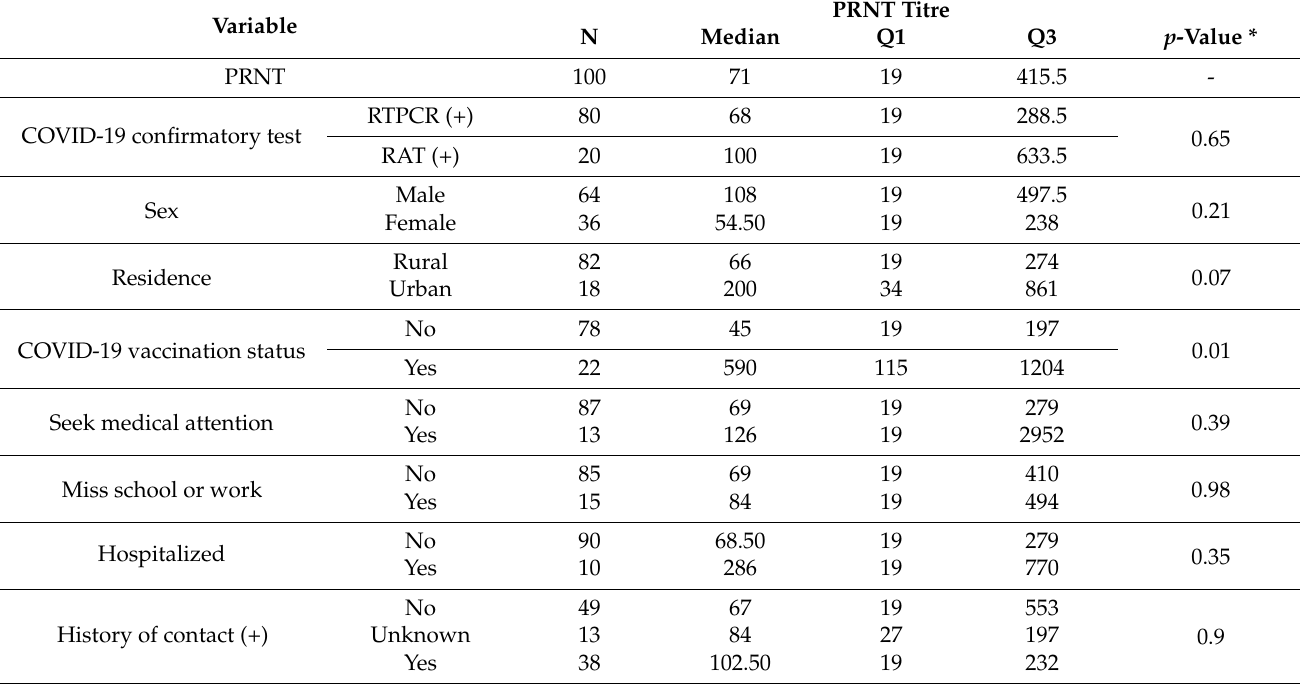
Table 1. Distribution of PRNT titre by sociodemographic and clinical